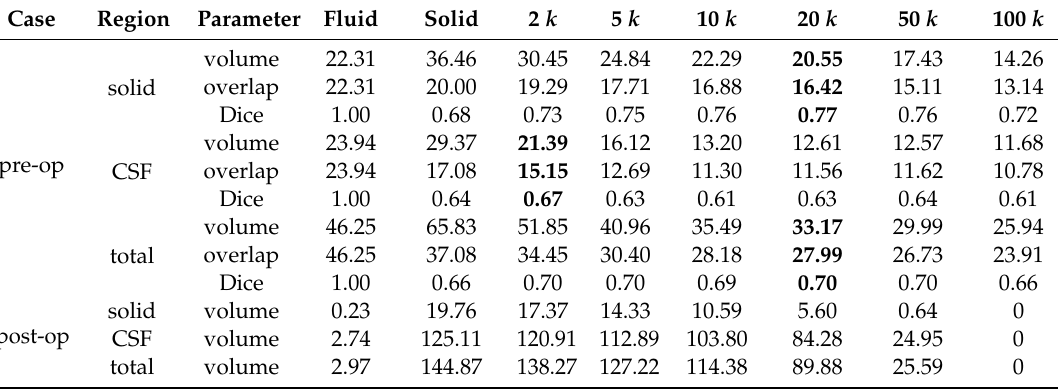
Table 2. Hot spot volume and overlap as predicted by the various models and cases are shown. For the pre-operative case, the volume of the hot spots (in mL) in healthy tissue is given, the overlap with the volume according to the convective fluid model, and the Dice coe ffi cient of the overlap; this is done separately for the solid tissues (except tumour and tumour cyst), the CSF, and the combination. The model having the highest Dice coe ffi cient is rendered in boldface. For the post-operative case, only the volumes (in mL) are given, as the convective fluid model predicts hardly any hot spots and all Dice coe ffi cients are <